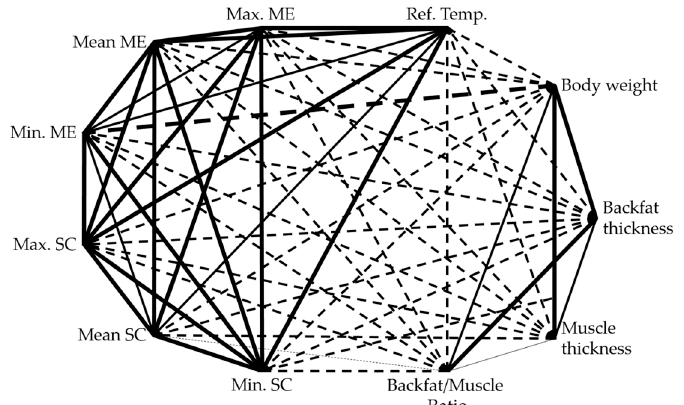
Figure 5. A significant correlation ( p < 0.0001) for all measurements on all three measurement days between body surface temperature measured with ME and SC, reference temperature, and body condition parameters like bodyweight, backfat thickness, muscle thickness, and backfat/muscle ratio. Continuous lines indicate positive correlations, and dotted lines indicate negative correlations. The thicker the connecting line, the stronger the correlation, with R > |0.3| as weak, R > |0.5| as mean and R > |0.8| as strong correlation.